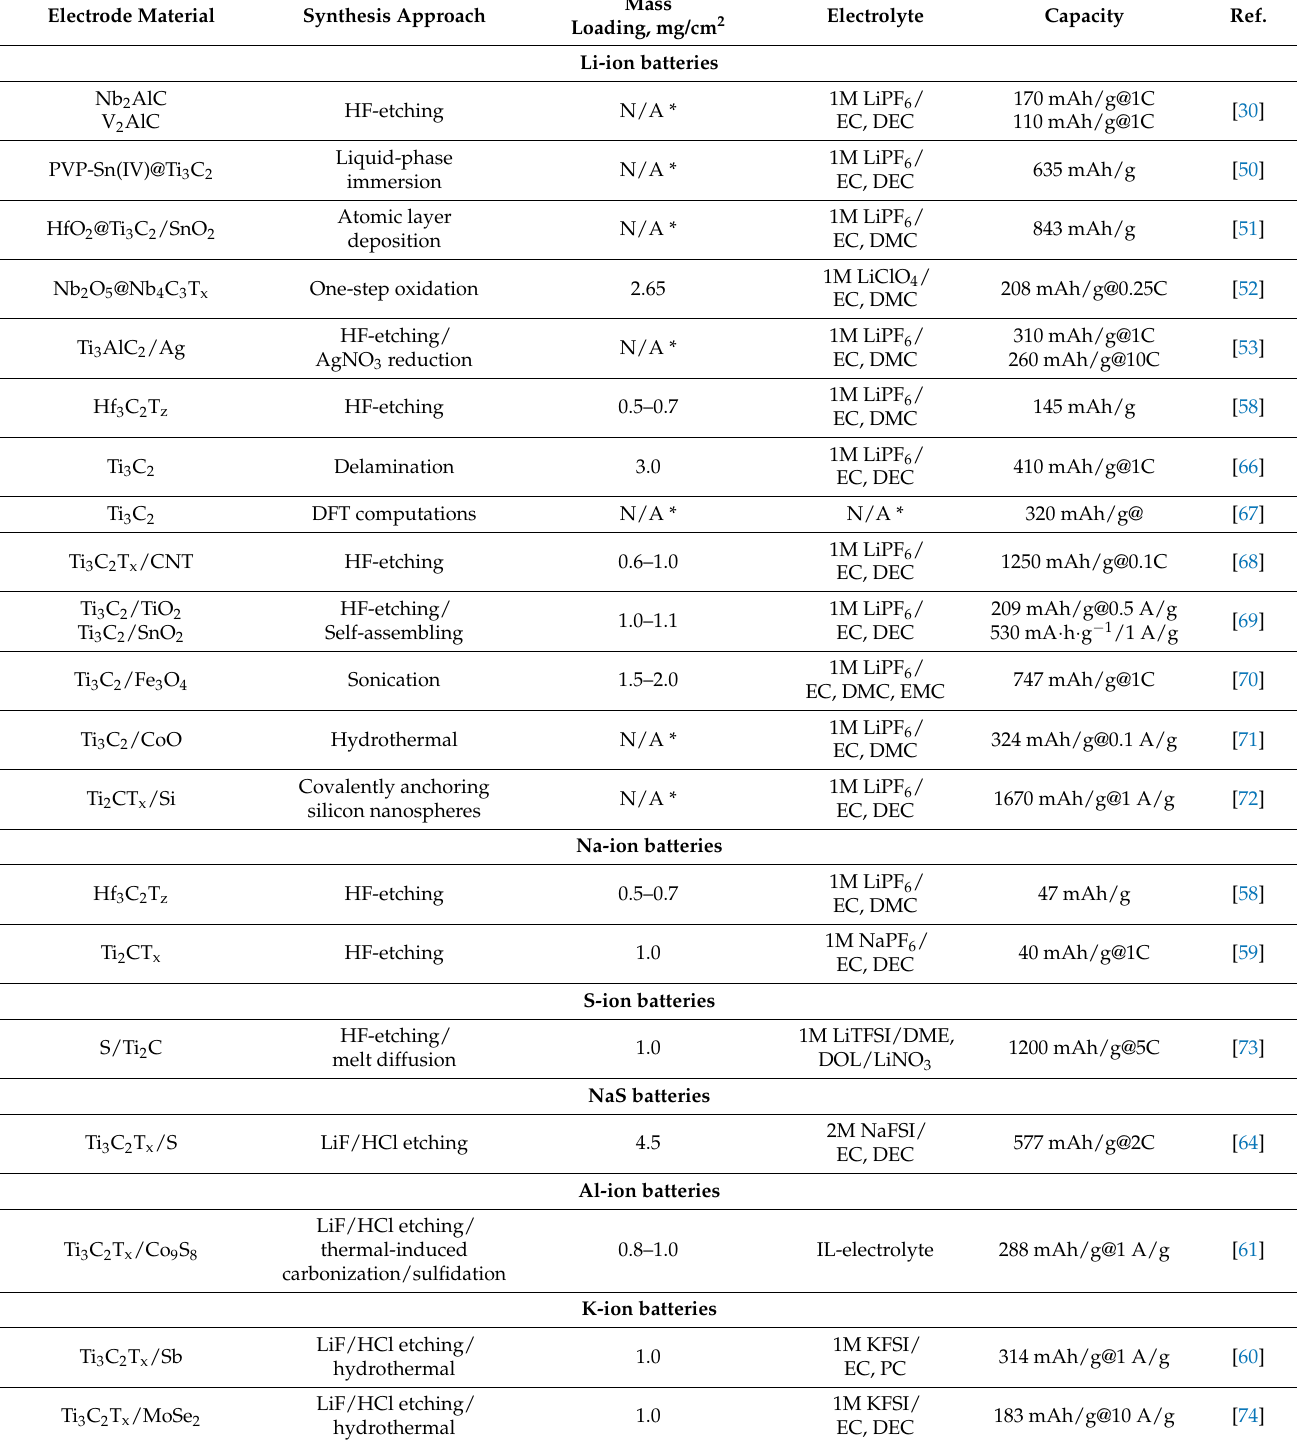
Table 1 summarizes the performance of MXenes and MXene-based composites in different battery types. Table 1. Performance of MXene-based structures in